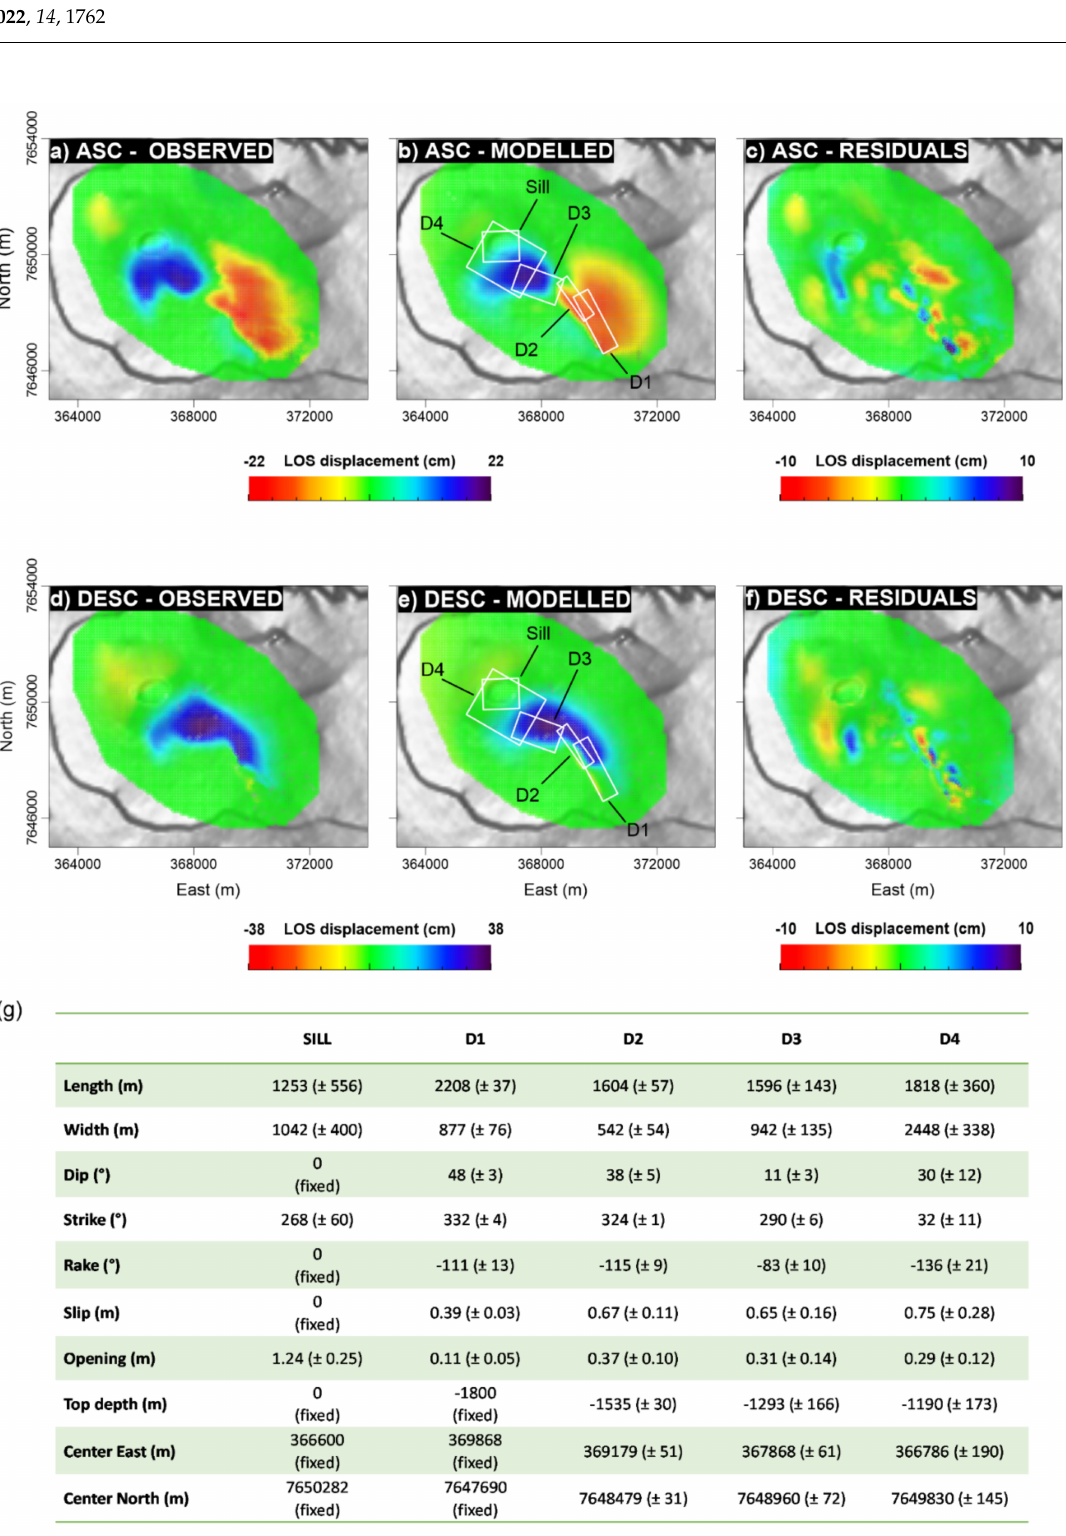
Figure 4. Non-linear inversion results: we report the line-of-sight (LOS) projected displacement maps for the S1 ascending ( a ) and descending ( d ) orbits interferograms, and the LOS projected displacement maps computed from the retrieved analytical model for the S1 ascending ( b ) and descending ( e ) orbits interferograms. The corresponding residual maps are shown in ( c , f ), respectively. The retrieved solutions are also marked by white rectangles. The reported maps are superimposed on the 1 arcsec Shuttle Radar Topography Mission (SRTM) Digital Elevation Model (DEM) of the zone. ( g ) Best- fit parameters of the volcanic sources retrieved from the non-linear inversion modeling; the 1- σ uncertainty is also